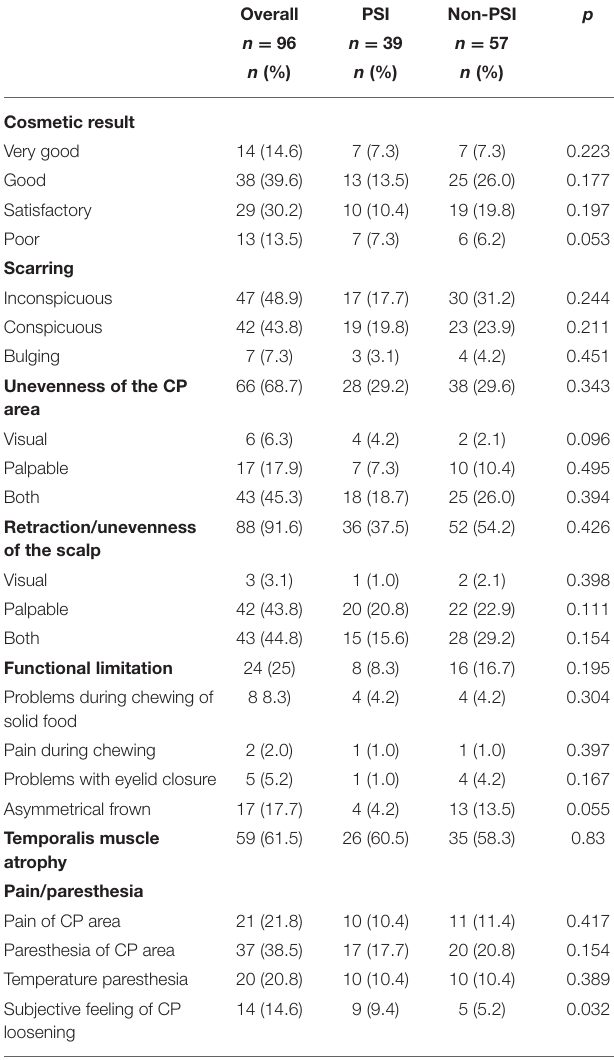
non-PSI ( n , number; %, proportion). Overall PSI